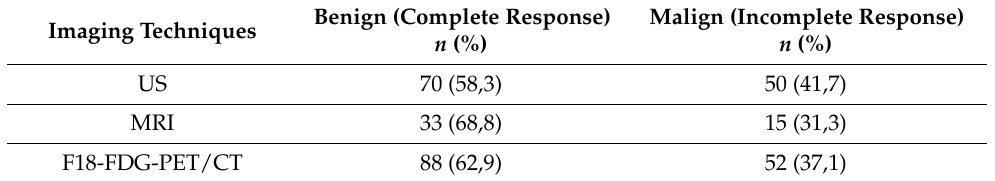
Table 2. Imaging Techniques outcomes.